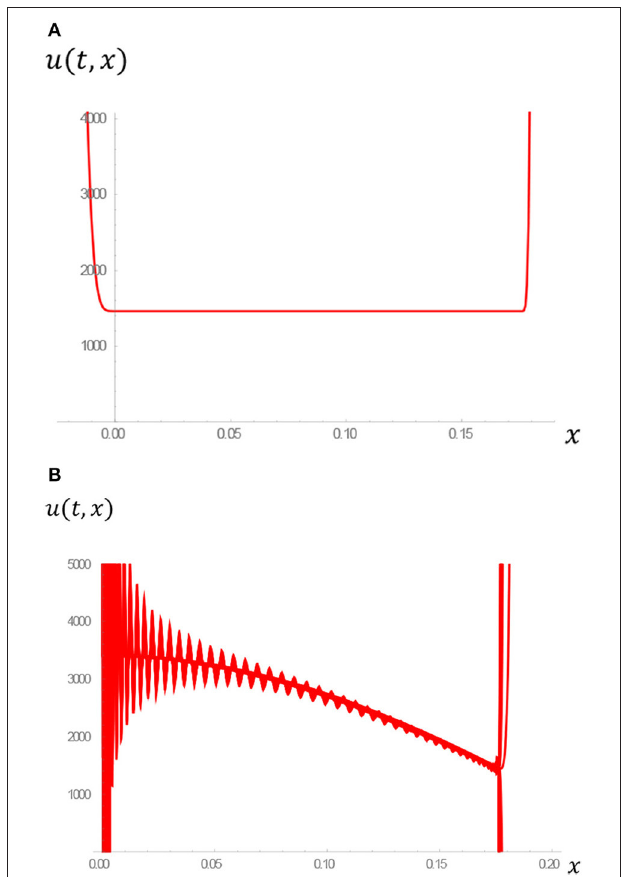
FIGURE 3 | (A) Sinusoidal shock-wave solution for Equation (34), for the appropriate frequency ω ∼= 6.412, satisfying the required boundary conditions of the shock-wave of velocity, u ( t , x ) , over the fixed spatial-interval 0 ≤ x ≤ 0.176m up to a time period of 1s. (B) Sinusoidal solution of Equation (42), with ω ∼= 6.412, of a shock-wave solution curve, with velocity u ( t , x ) , over the fixed spatial interval 0 ≤ x ≤ 0.176m up to a time period of 1s. Note that the transitory shock-wave’s minimum velocity within this model is 1461.794 m/s, and does not actually reduce to zero, nor becomes negative in value, as this oscillatory graphical-plot appears to suggest for a larger spatial-range. This solution indicates the sinusoidal nature of the type of function chosen, resulting in two shock-discontinuities at x = 0 and x = 0.176m over the given spatial-range, described perhaps more clearly in (A) ( Figures 4 , 5 ).